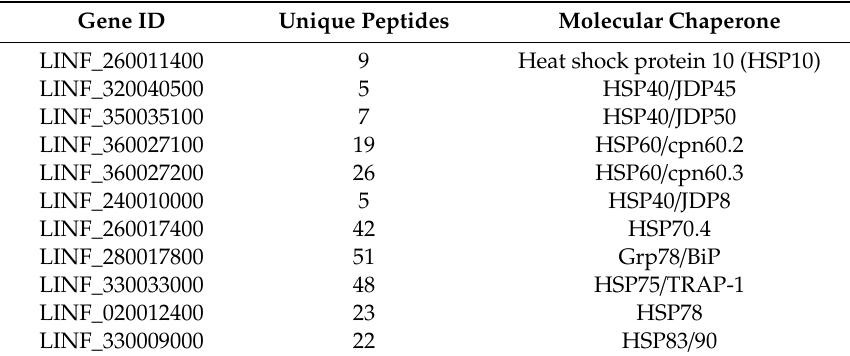
Table 3. Identified molecular chaperones of L. infantum promastigotes, with putative mitochondrial location (according to Tasbihi et al.